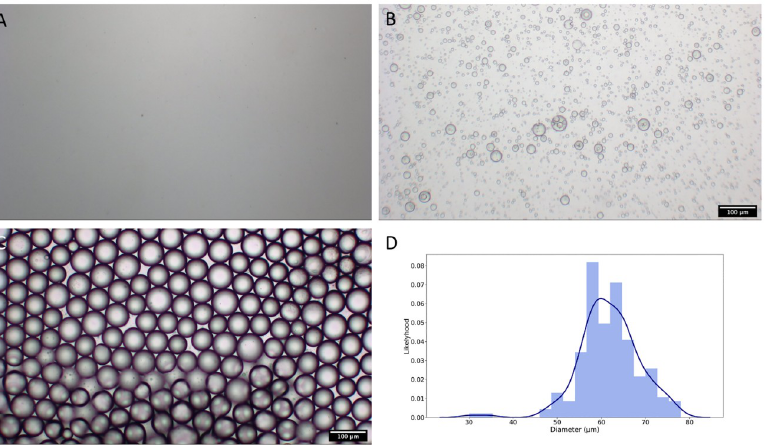
Fig 2. The s/o/w miriplatin emulsion. (A) Image of conventional miriplatin suspension (100 × magnification). (B) Image of miriplatin s/o/w emulsion prepared using three-way stopcock without adding surfactant (100 × magnification). (C) Image of miriplatin s/o/w emulsion, used in the experiment, prepared using SPG membrane with adding surfactant (100 × magnification). (D) Results of kernel density estimation. The mode droplet size was 60.0 μ m. The data was calculated based on droplet diameters obtained from the microscopic